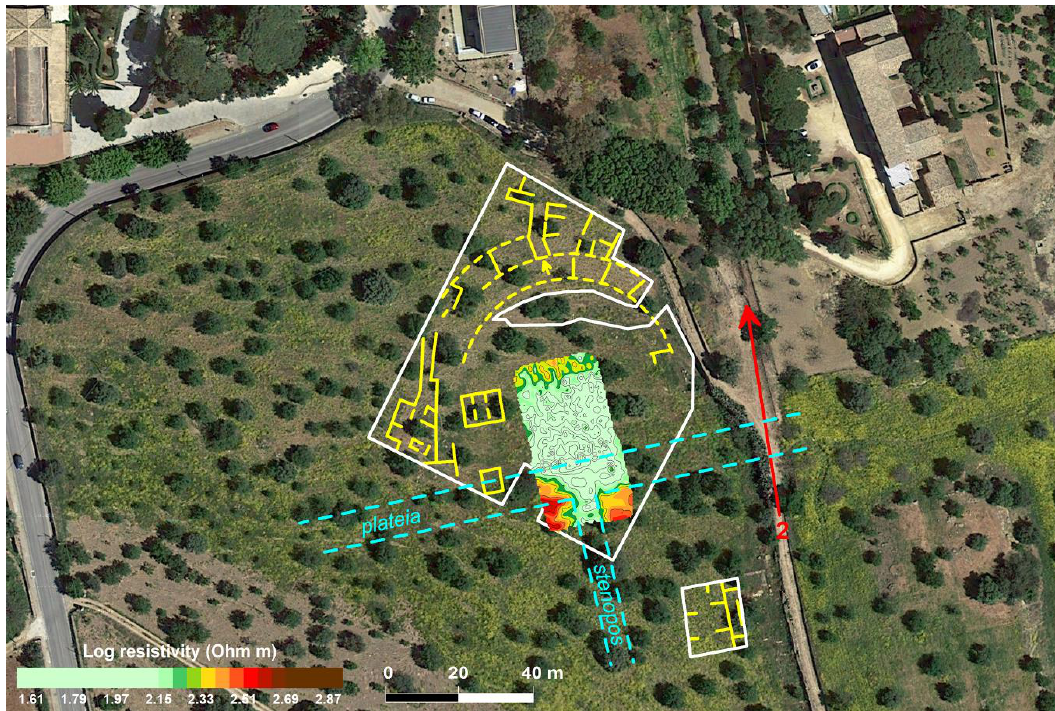
Figure 11. Modelled electrical resistivity map relative to 3.5 m in depth in relation to the features detected at 1 m in depth (indicated with yellow color).